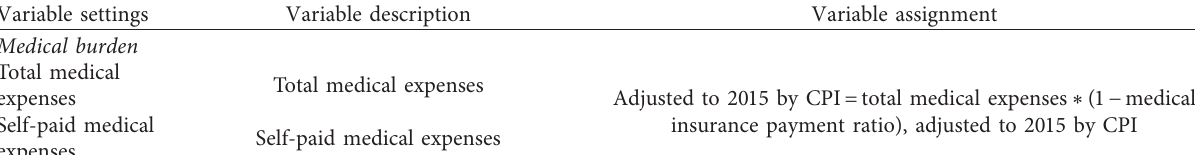
Table 1: Variable description and